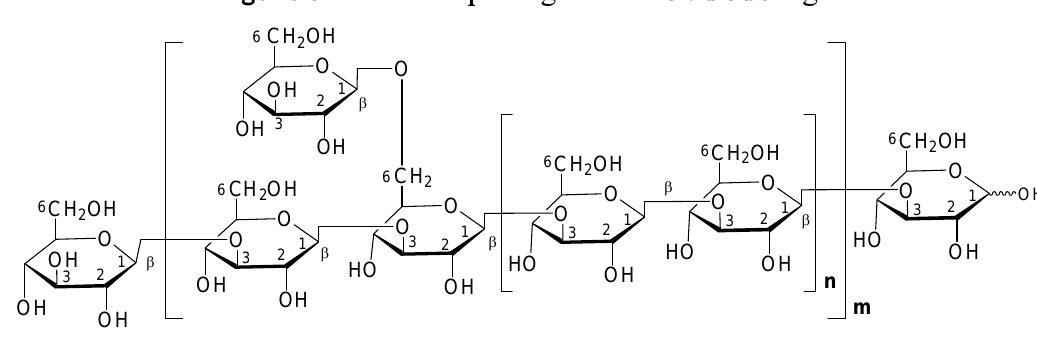
Figure 5 . Possible repeating units of G. lucidum glucans.